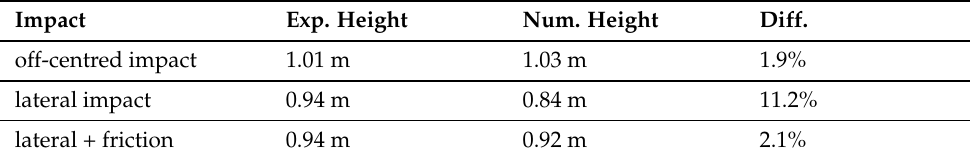
Table 9. Residual height for the off-centred impact and the lateral impact. Impact Exp. Height Num. Height Diff. off-centred impact 1.01 m